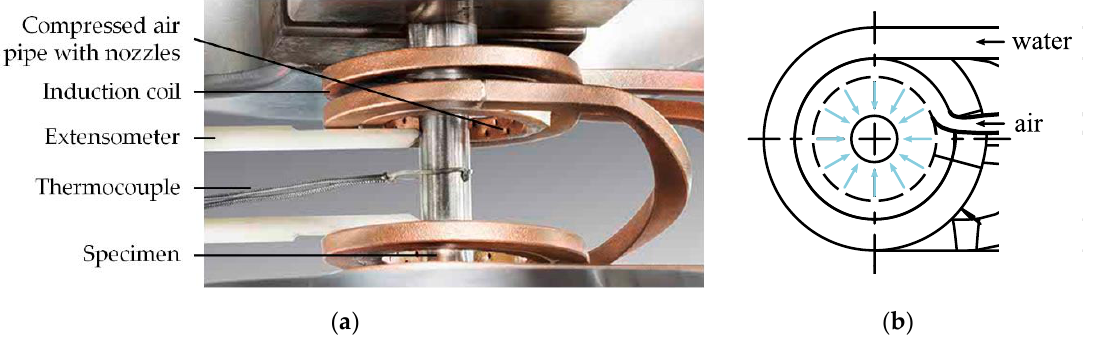
Figure 2. ( a ) Thermomechanical fatigue (TMF) test setup. ( b ) Induction coil with outer water-cooled